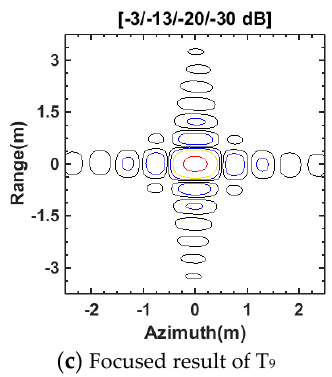
Figure 13. Focused point target results of T 7 , T 8 , and T 9 : ( a ) focused result of T 7 ; ( b ) focused result of T 8 ; and ( c ) focused result of T 9 .